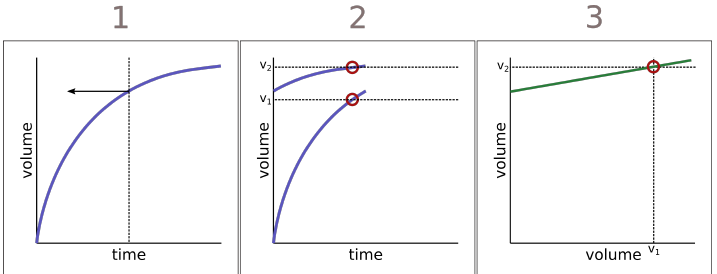
Figure 2. A procedure for estimating dynamical symmetries implicit in a single, passively observed time series under the assumption of time-invariance. In step 1 (leftmost panel), we choose a time t midway through the time series and, in step 2, treat the data from ∀ t (cid:48) ( t (cid:48) > t ) as though it came from a fresh time series with a different initial condition. In step 3, we estimate a dynamical symmetry as before by plotting the values of one curve as a function of the contemporary point on the